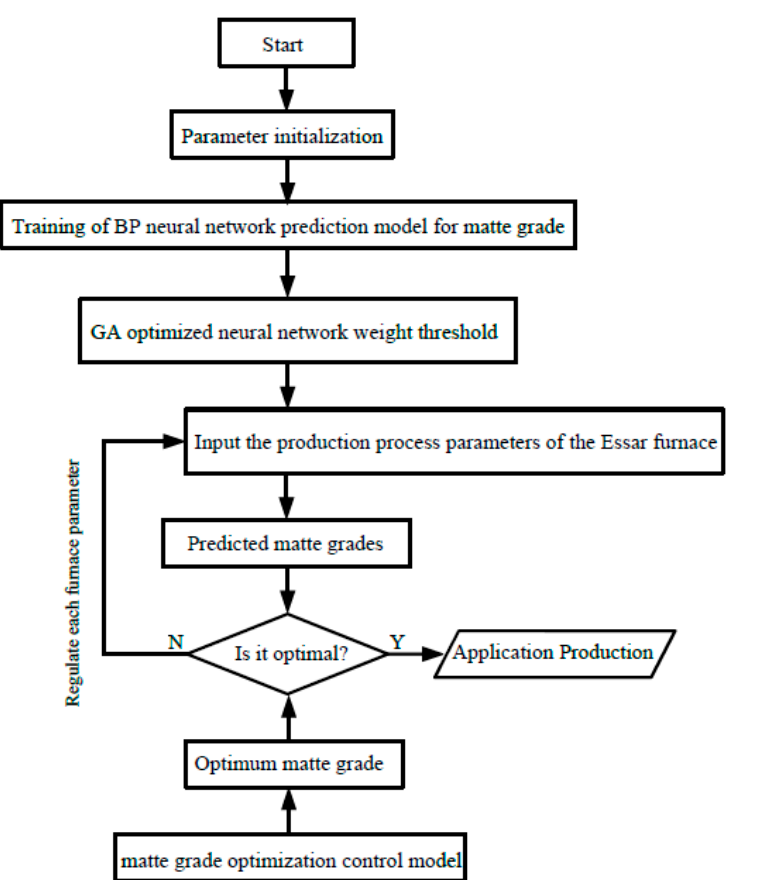
Figure 3. GA-BP neural network ISA smelting matte-grade optimization and prediction model solution flow chart.